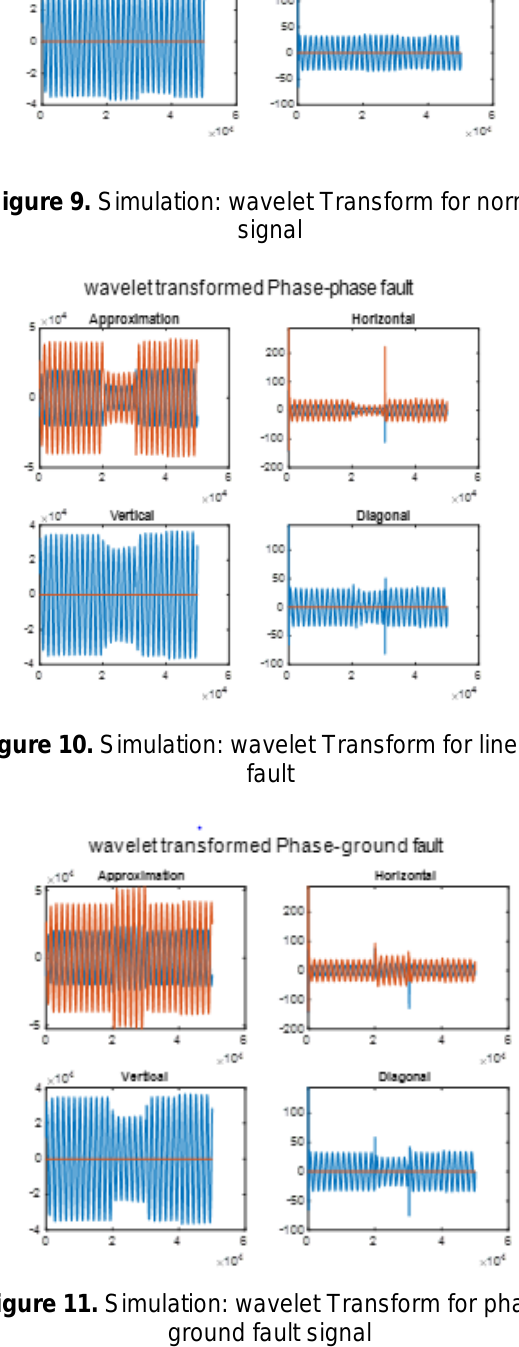
Figure 11. Simulation: wavelet Transform for phase- ground fault